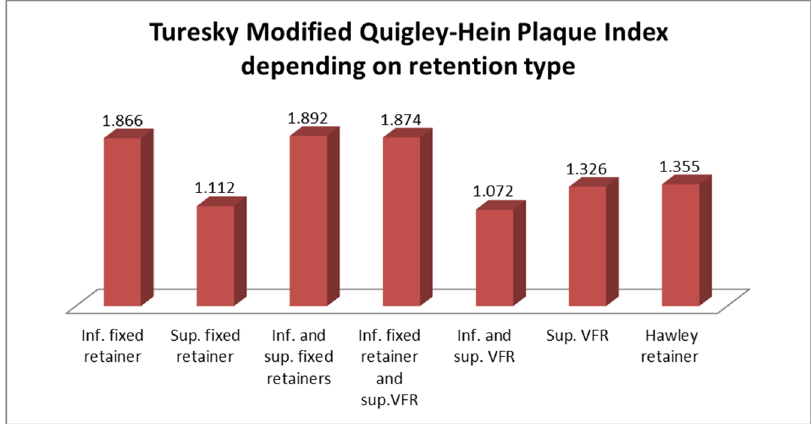
Figure 10. Turesky Modified Quigley-Hein Plaque Index, female study group.